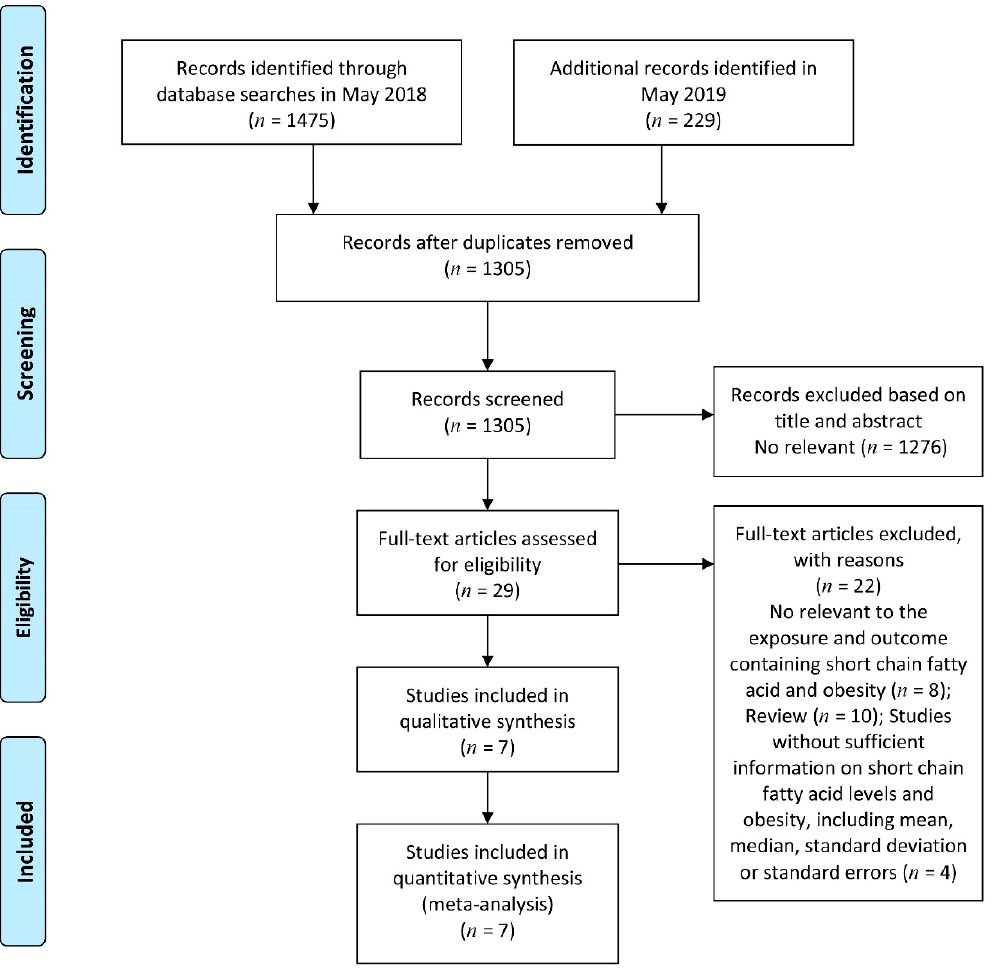
Figure 1. Flow diagram of the search strategy and study selection process.